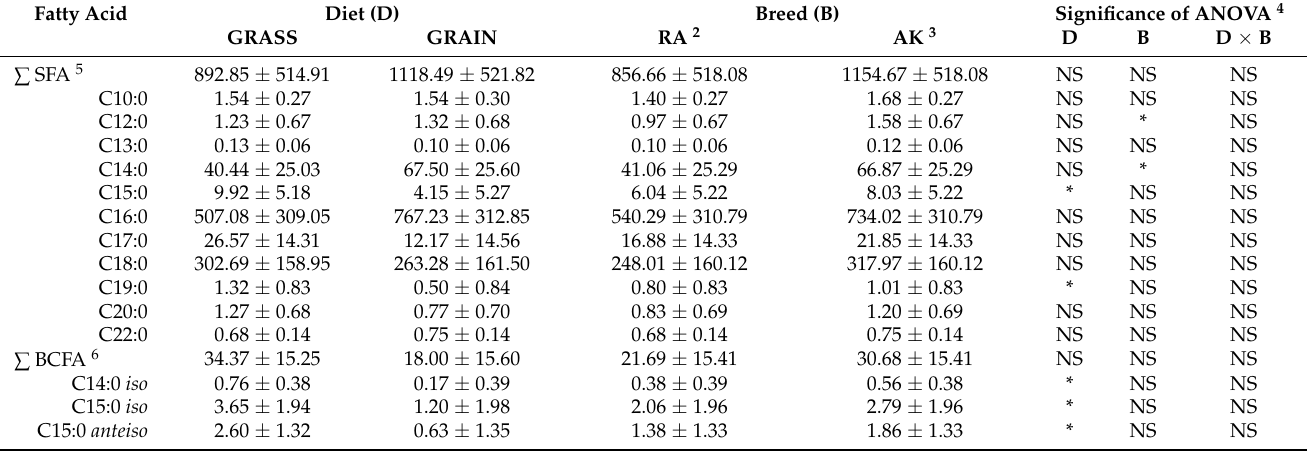
Table 2. Mean concentrations of saturated and monounsaturated fatty acids in beef by diet, breed, and diet × breed interaction (mg per 100 g meat) 1